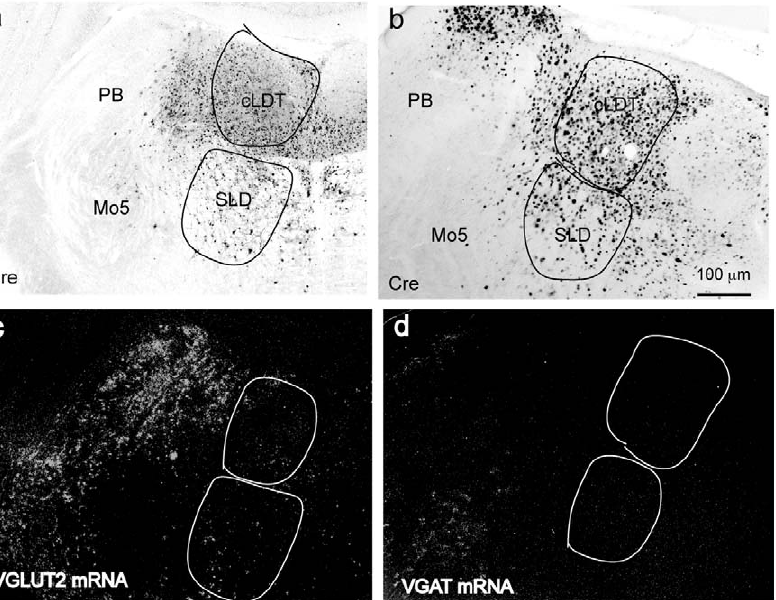
Figure 2. Verification of VGAT and VGLUT2 mRNA knockout in the cLDT-SLD. The white dots of ‘‘c’’ and ‘‘d’’ label VGLUT2 mRNA and VGAT mRNA in the cLDT-SLD respectively. The AAV-Cre injections in the cLDT-SLD region in a Vglut2 flox/flox mouse (a) eliminate VGLUT2 mRNA (c) the glutamatergic PB that is not transfectionby AAV-Cre retains VGLUT2 mRNA. Similarly, AAV-Cre in the cLDT-SLD in a Vgat flox/flox mouse (b) eliminates VGAT mRNA (d).